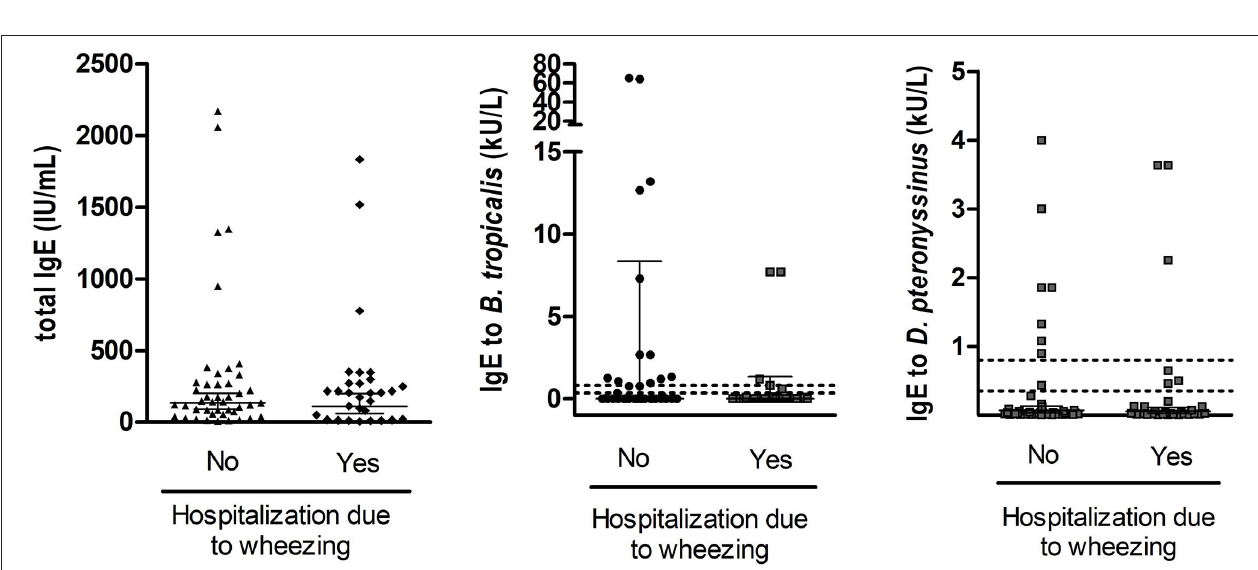
FIGURE 4 | Distribution of total and specific IgE levels in 74 children in which blood tests were available 2 weeks after discharge according to the antecedent of hospitalization in the previous year due to wheezing. Each dot represents an individual, error bars indicate geometric mean and 95% confidence interval. Discontinuous lines indicate the 0.35 and the 0.8 kU/l cut-off for positive IgE